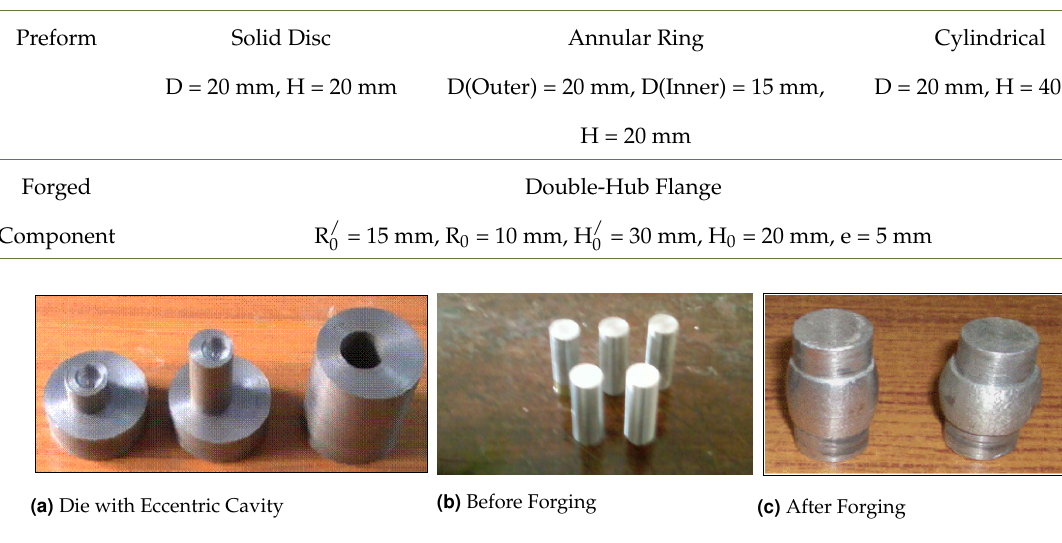
Fig. 1. Closed-Die Forging Set and AMC